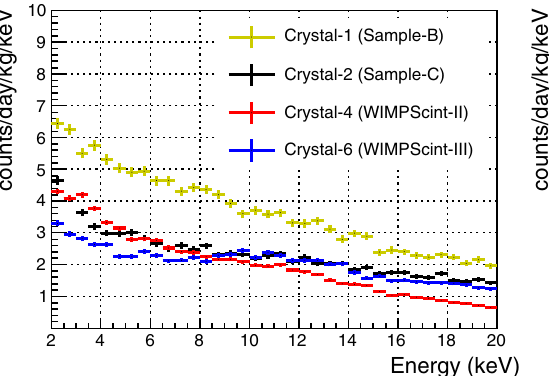
each crystal. Crystal-4 and Crystal-6 have been underground for less than 1year and so cosmogenic peaks (e.g. 125 I at 67.8keV) are addi- tionally seen. These spectra are obtained using 59.5 days of the initial data. We have estimated efficiencies at 2keV better than 95% using 60 Co Compton calibration data. Therefore, efficiency corrections are not